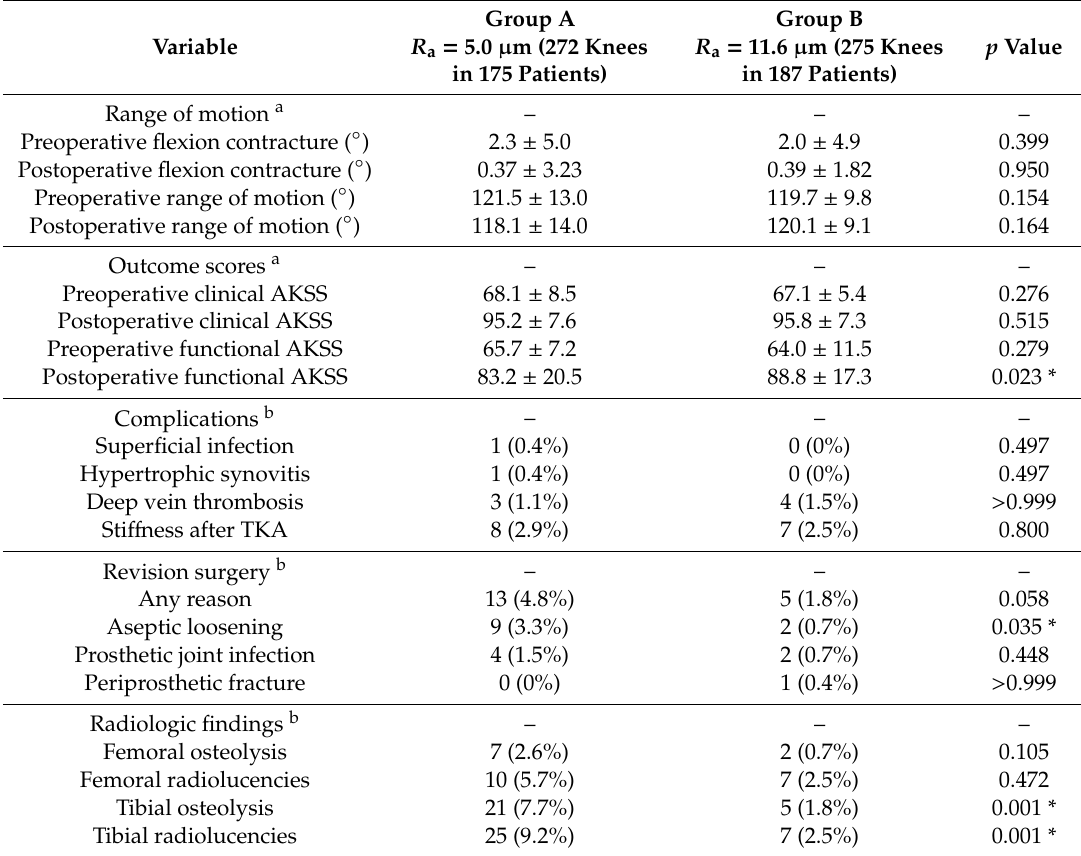
Table 2. Clinical and radiological